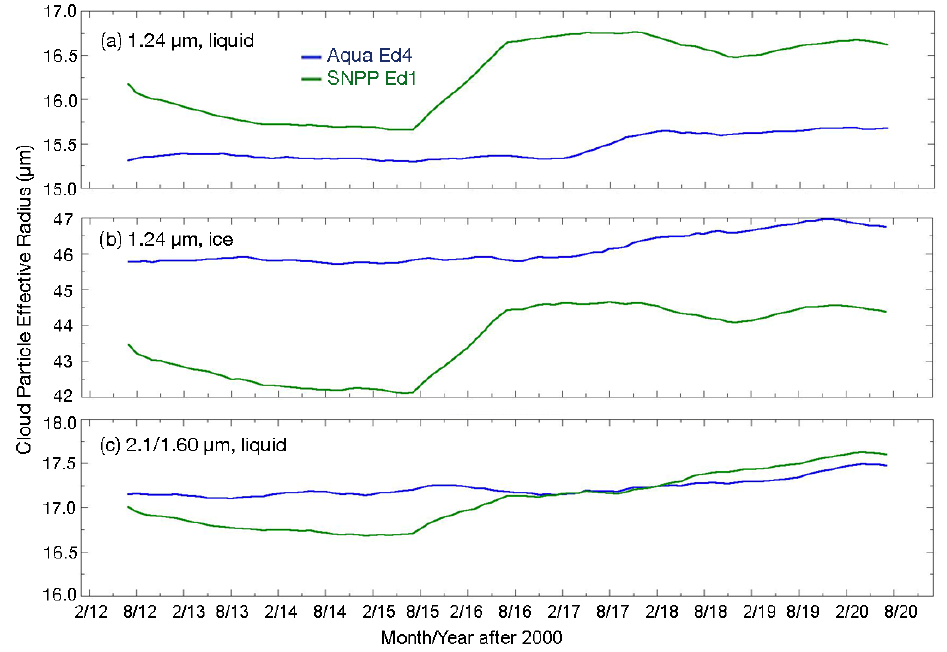
Figure 16. Same as Figure 11, except for the CER retrieved using the 1.24-µm channel for ( a ) liquid, CER7w , and ( b ) ice clouds, CER7i , and ( c ) 2.1 or 1.6-µm for liquid clouds, CER2w .